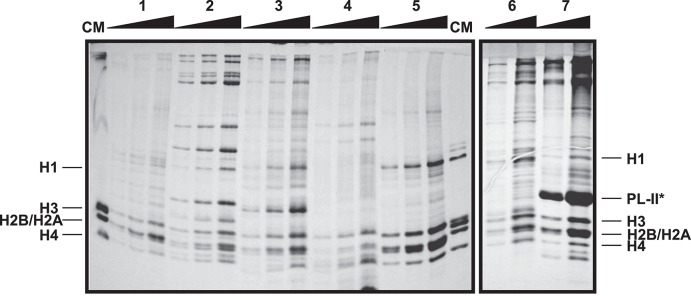
Electrophoretic analysis of histone and SNBP acid extractions from different tissues of the mussel Mytilus californianus. SDS-PAGE of histone extracts from hepatopancreas (1), muscle (2), male gonad (3), hemolymph (4), and gill (5), and histone and SNBP extracts from female gonad (6) and sperm (7). CM, chicken erythrocyte histones used as molecular marker. Band corresponding to PL-II* in sperm tissue was identified based on our previous work (Gonzalez-Romero et al., 2012b). For each tissue, pellet resulting from the protein acid extraction (from 1 g of starting material) was resuspended in 100 μL of ultrapure-water, diluted in the same amount of SDS Sample Buffer and loaded 1, 2 and 4 μL in the SDS gel. Gradients in the upper part of the gel indicate the increase in the relative concentration of the proteins loaded in each lane.